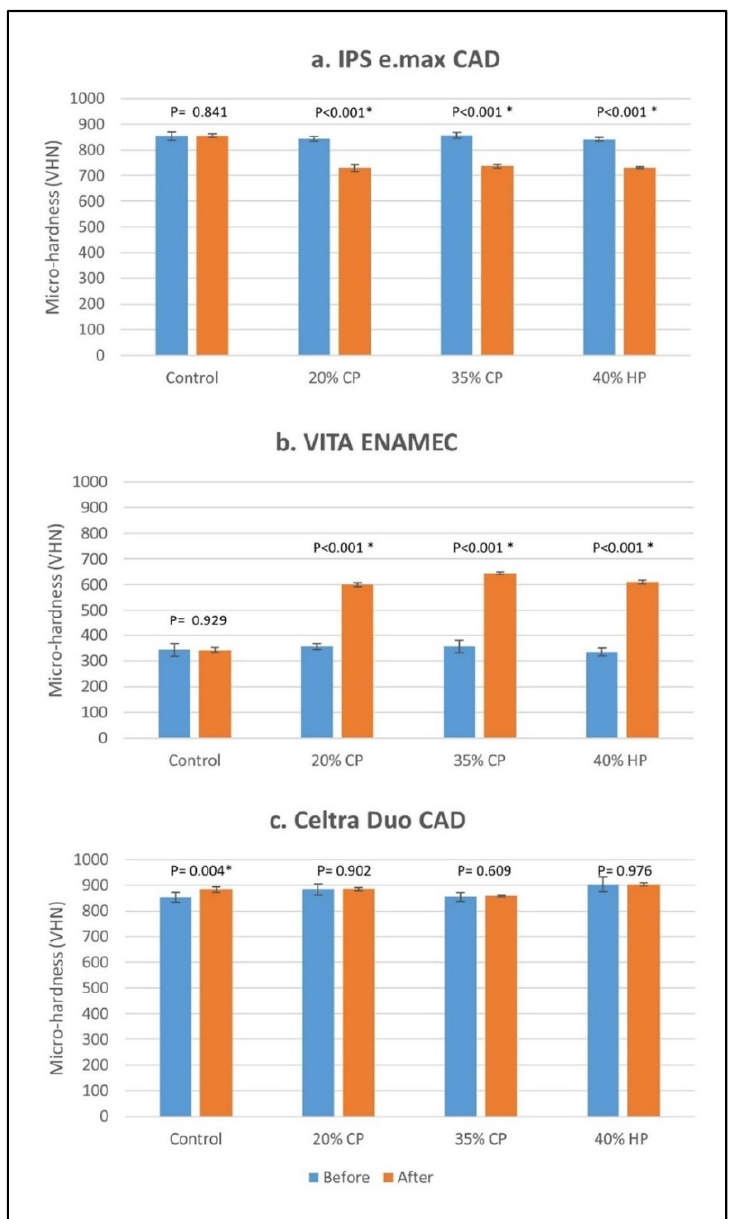
Figure 4. Vickers microhardness of the different ceramic materials before and after bleaching. Significant differences between values before and after bleaching are denoted with asterisk sign ( α = 0.05). CP and HP stand for carbamide peroxide and hydrogen peroxide, respectively.